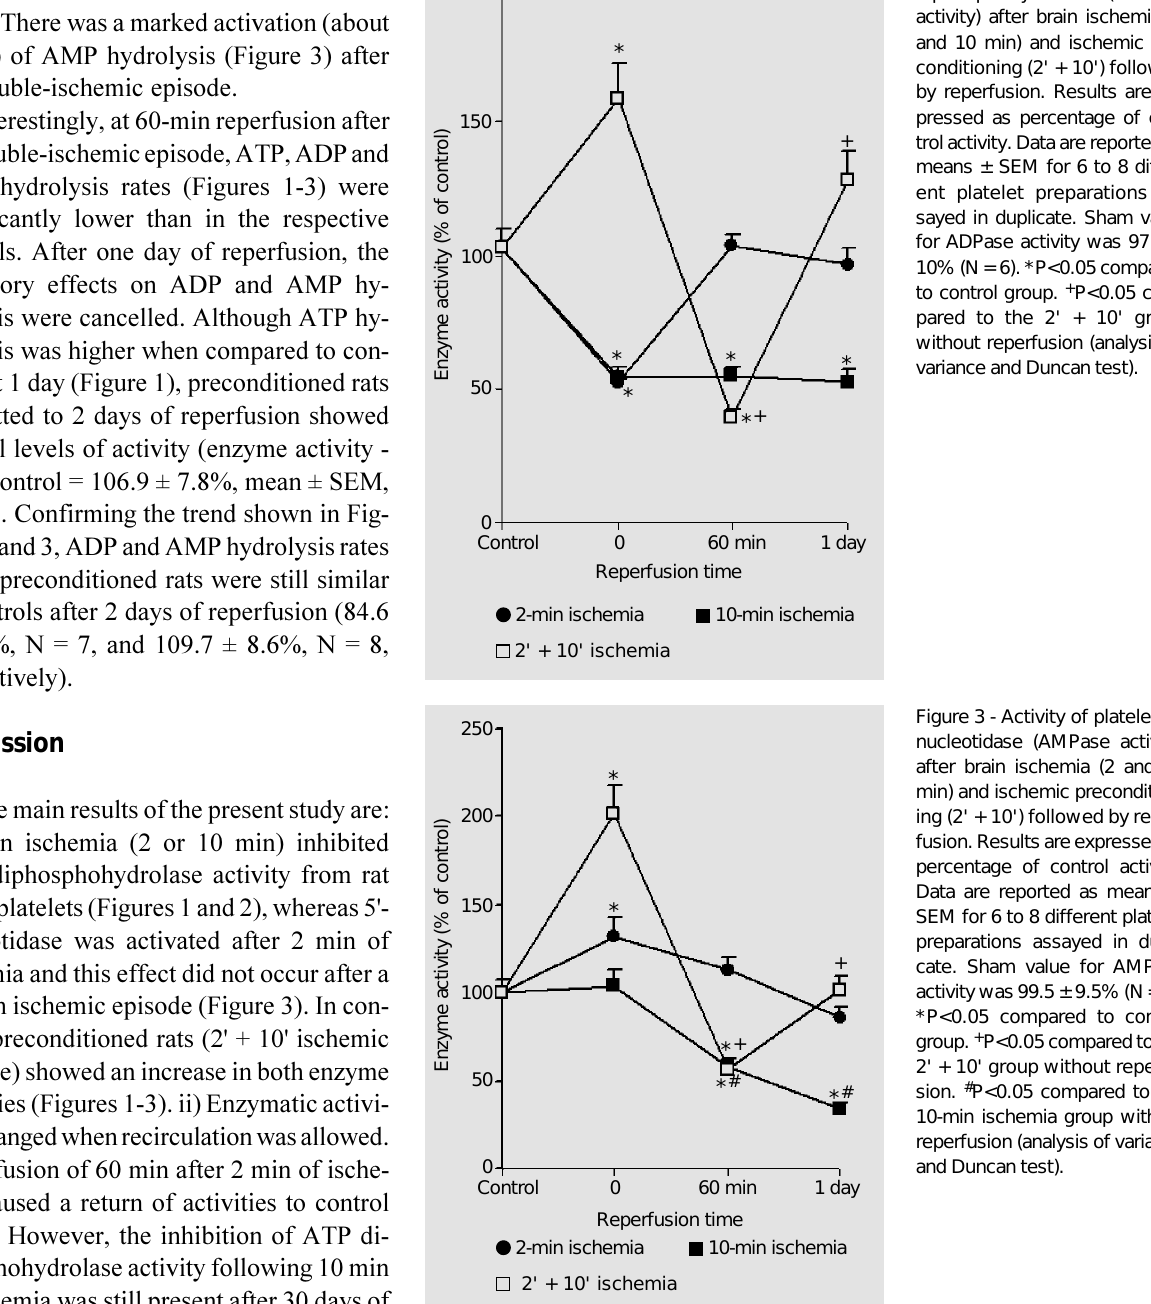
Figure 2 - Activity of platelet ATP diphosphohydrolase (ADPase activity) after brain ischemia (2 and 10 min) and ischemic pre- conditioning (2' + 10') followed by reperfusion. Results are ex- pressed as percentage of con- trol activity. Data are reported as means ± SEM for 6 to 8 differ- ent platelet preparations as- sayed in duplicate. Sham value for ADPase activity was 97.4 ±